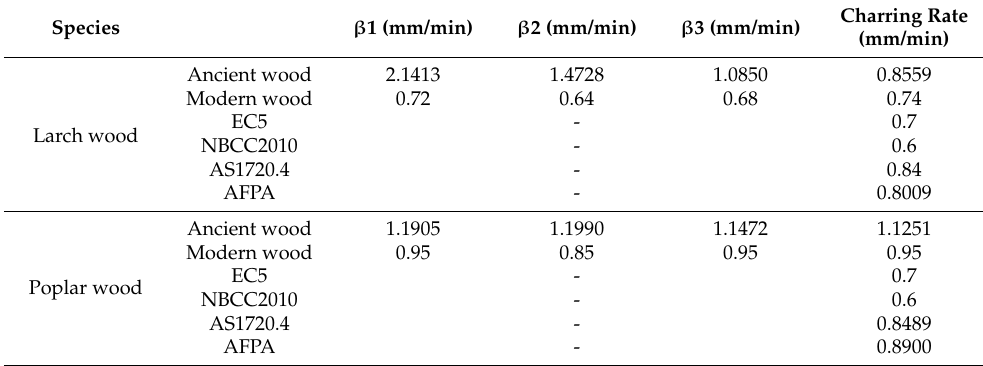
Table 6. Basic charring rates and standard recommended values for ancient and modern